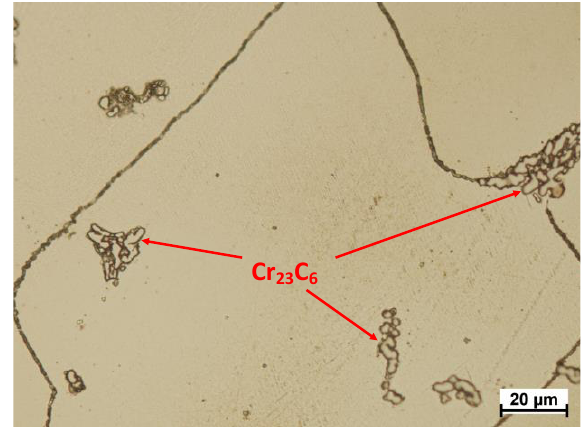
Figure 16. Distribution of carbides in the microstructure of the test material.